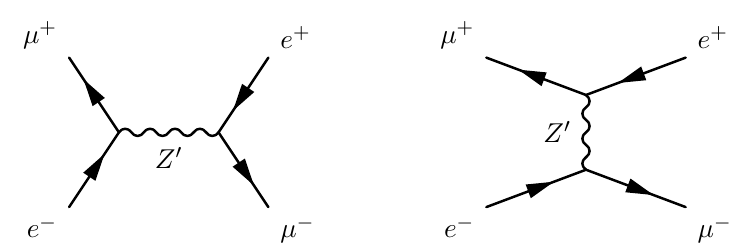
Figure 15 . Relevant diagrams leading to muonium-antimuonium